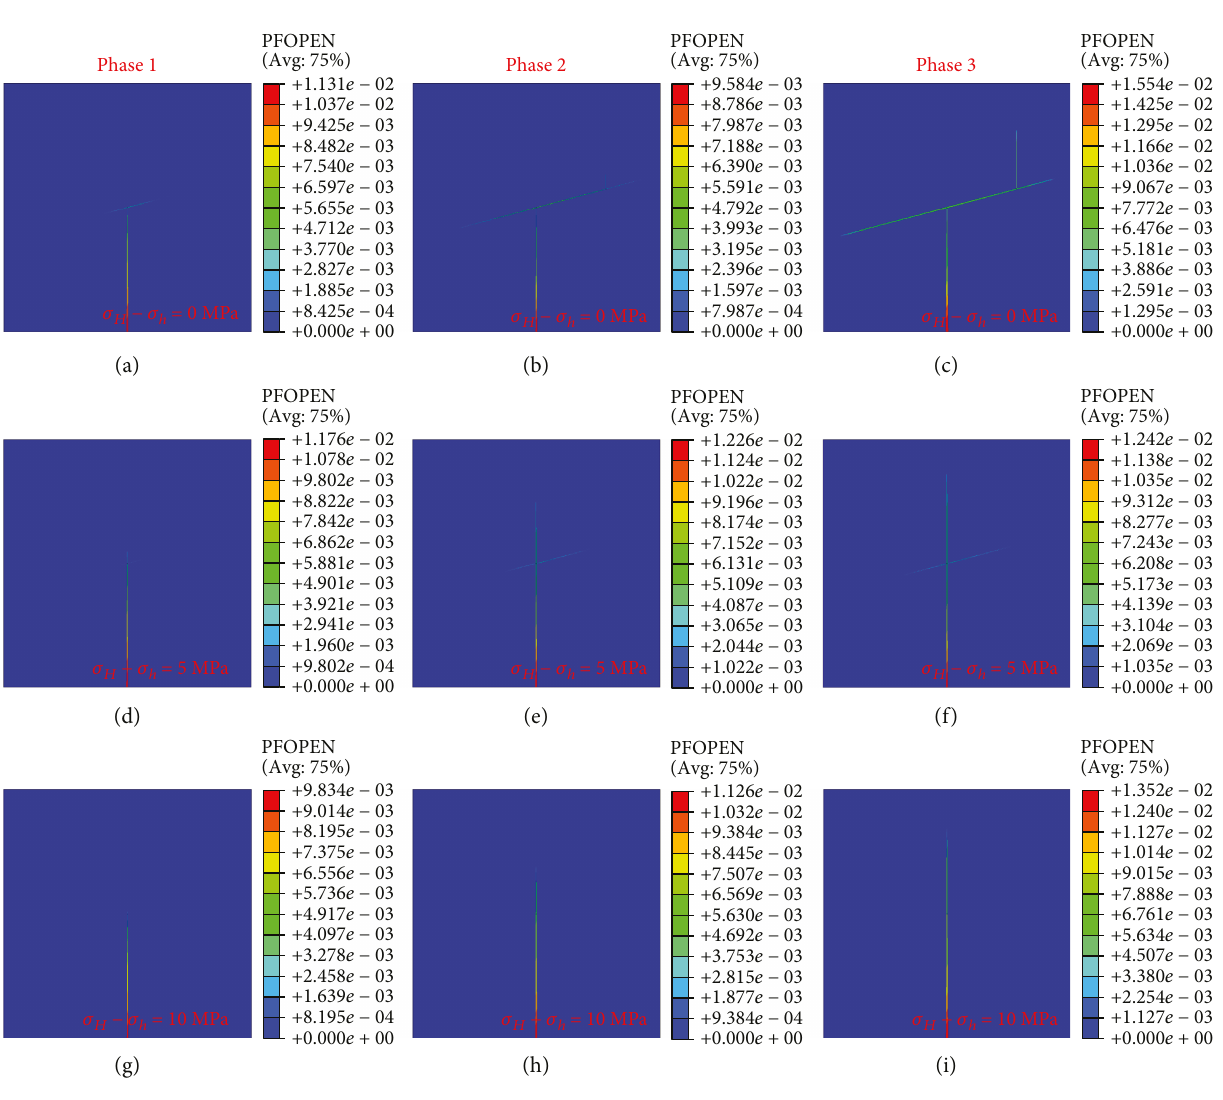
Figure 10: Approaching angle of 75 °